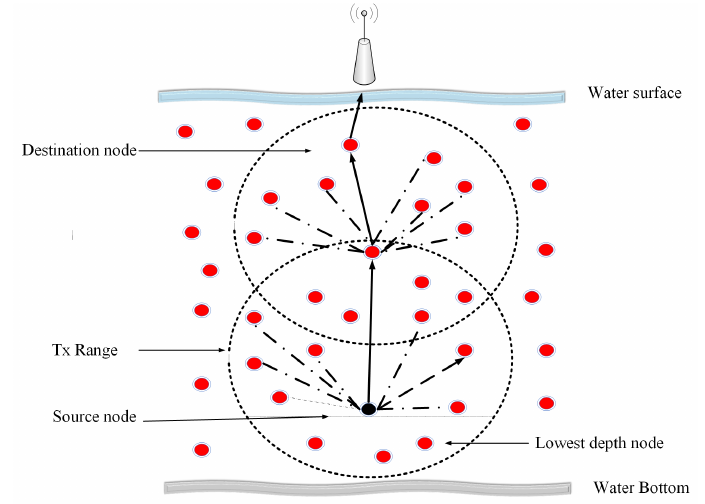
Figure 3. Data forwarding in EERD